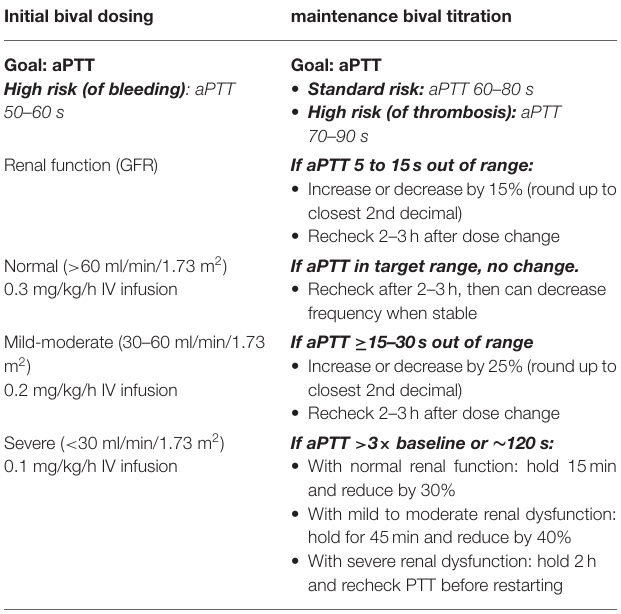
TABLE 5 | ACTION Harmonization recommendations for bivalirudin infusion for VADs. Initial bival